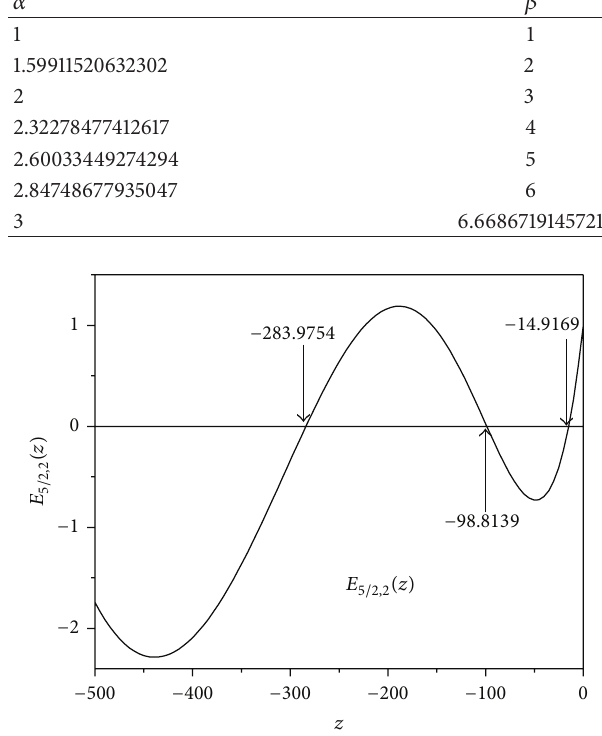
Figure 12: Typical Mittag-Leffler function in [ ∞/0 ].